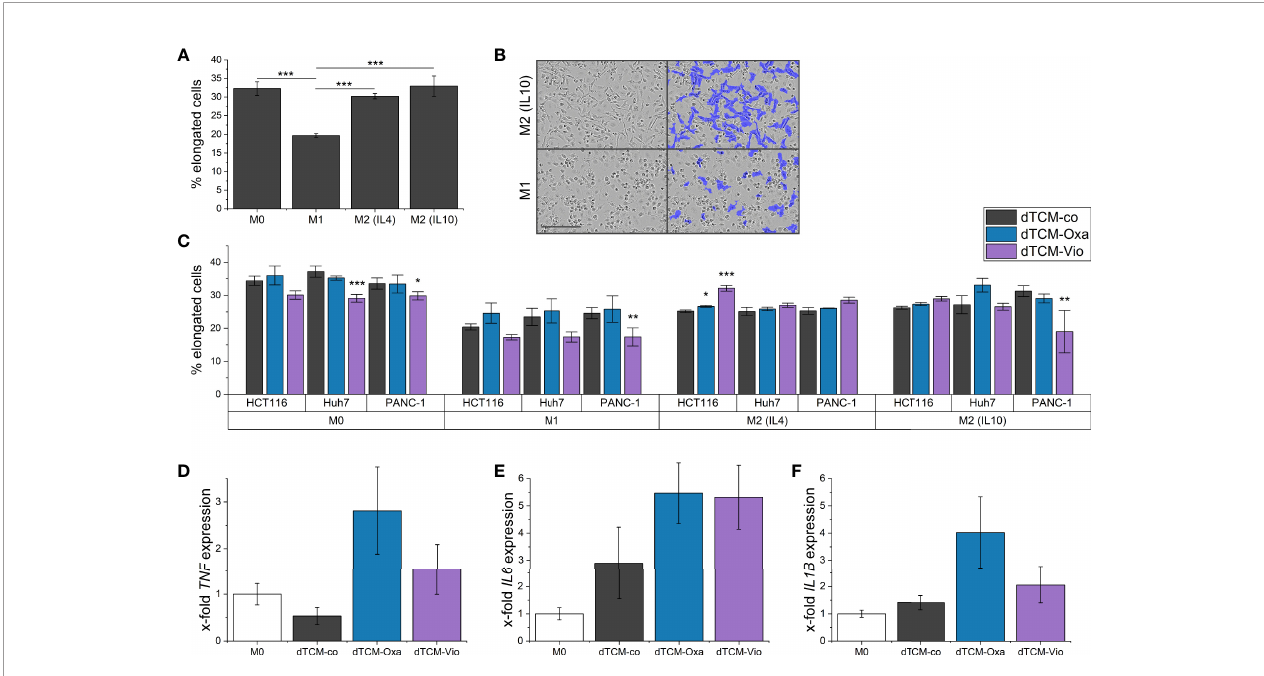
FIGURE 7 | The supernatant of violacein-killed tumor cells affects macrophage phenotype. HMDMs were differentiated and polarized in vitro into M0, M1, M2 (IL4), and M2 (IL10) macrophages for 24 h. (A) Differently polarized macrophages were imaged using the IncuCyte ® S3 system, and cells were grouped based on their eccentricity in an elongated or round morphology using the IncuCyte ® cell-by-cell analysis software. (B) Left: Representative pictures of M1 and M2 (IL10) macrophages are shown. Right: The violet mask labels the cells detected by the software as elongated. Scale bar = 200 µm. (C) Polarized macrophages were treated with dTCMs (37.5% v/v) from either HCT116, Huh7, or PANC-1 treated with either oxaliplatin (Oxa), violacein (Vio), or solvent control (co). Macrophage morphology was analyzed 48 h after treatment. n = 2 (triplicates). (D-F) M0 macrophages were treated with dTCMs (37.5% v/v) from Huh7 cells for 24 h. Gene expression was determined via qPCR and values were normalized to RNA18S as a housekeeping gene; 2 (triplicates). * p< 0.05, ** p< 0.01, *** p<0.001.